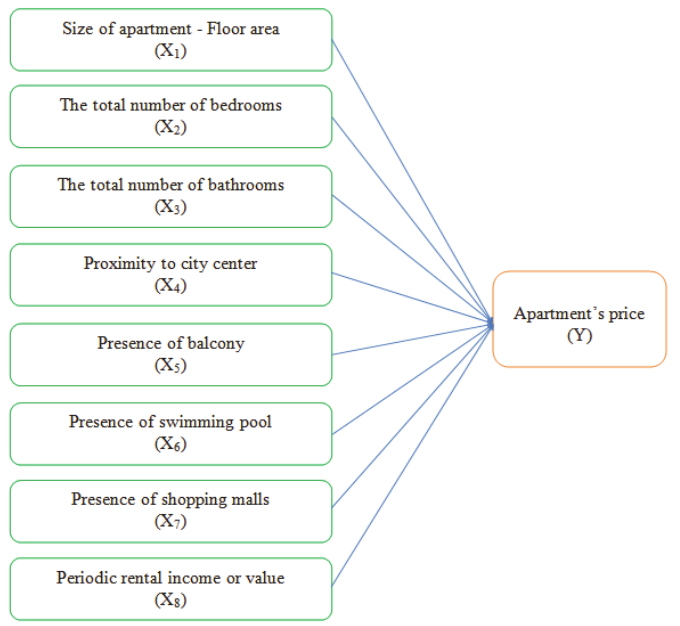
Fig. 1. Suggested research